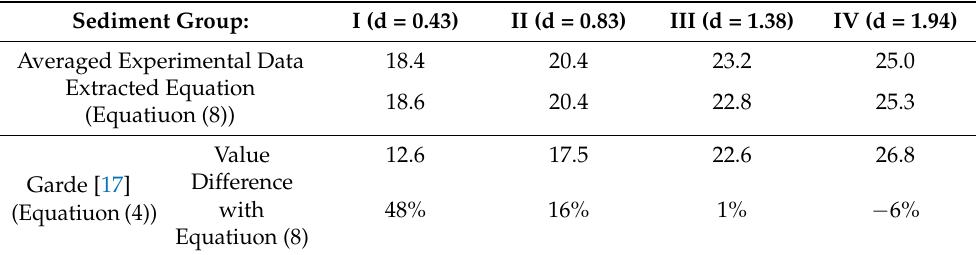
Table 5. Estimation of the threshold near-bed velocity using Equation (8) and those proposed by other researchers